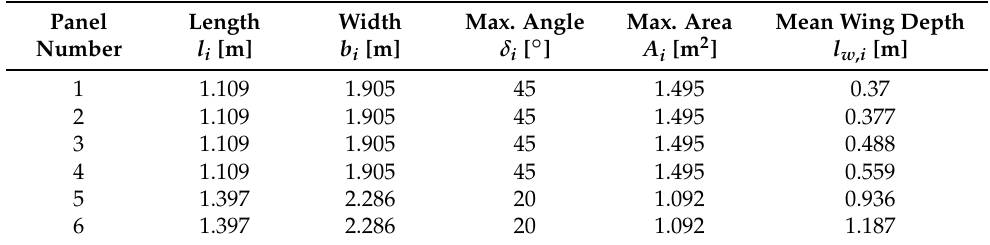
Table 1. Assumed geometric dimensions of the B747-100 speed brakes (Data collected from [43]). The Panels are numbered from outside to inside (see Figure 3). Panel Length Width Max. Angle Max. Area Mean Wing Depth l i